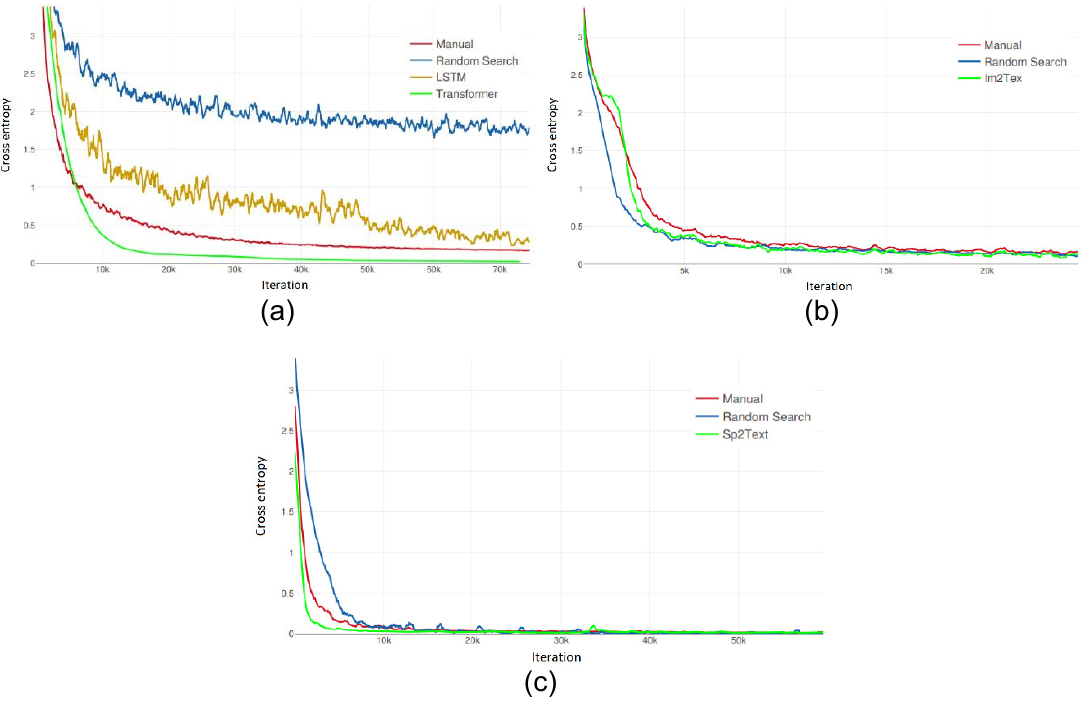
Figure 3. Evolution of the training errors (cross entropy) of the different models compared, for the three problems of interest. ( a ) Text translation. ( b ) LaTeX decompilation. ( c ) Audio